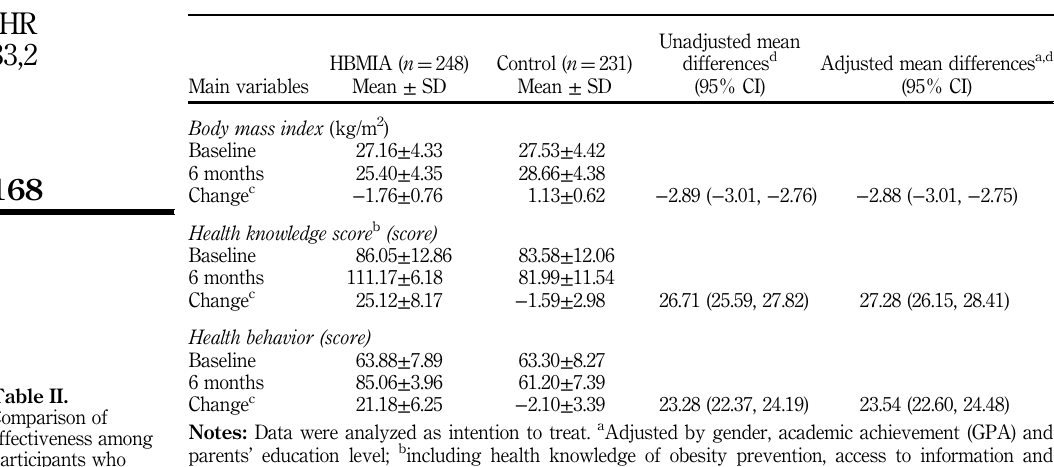
Table II. Comparison